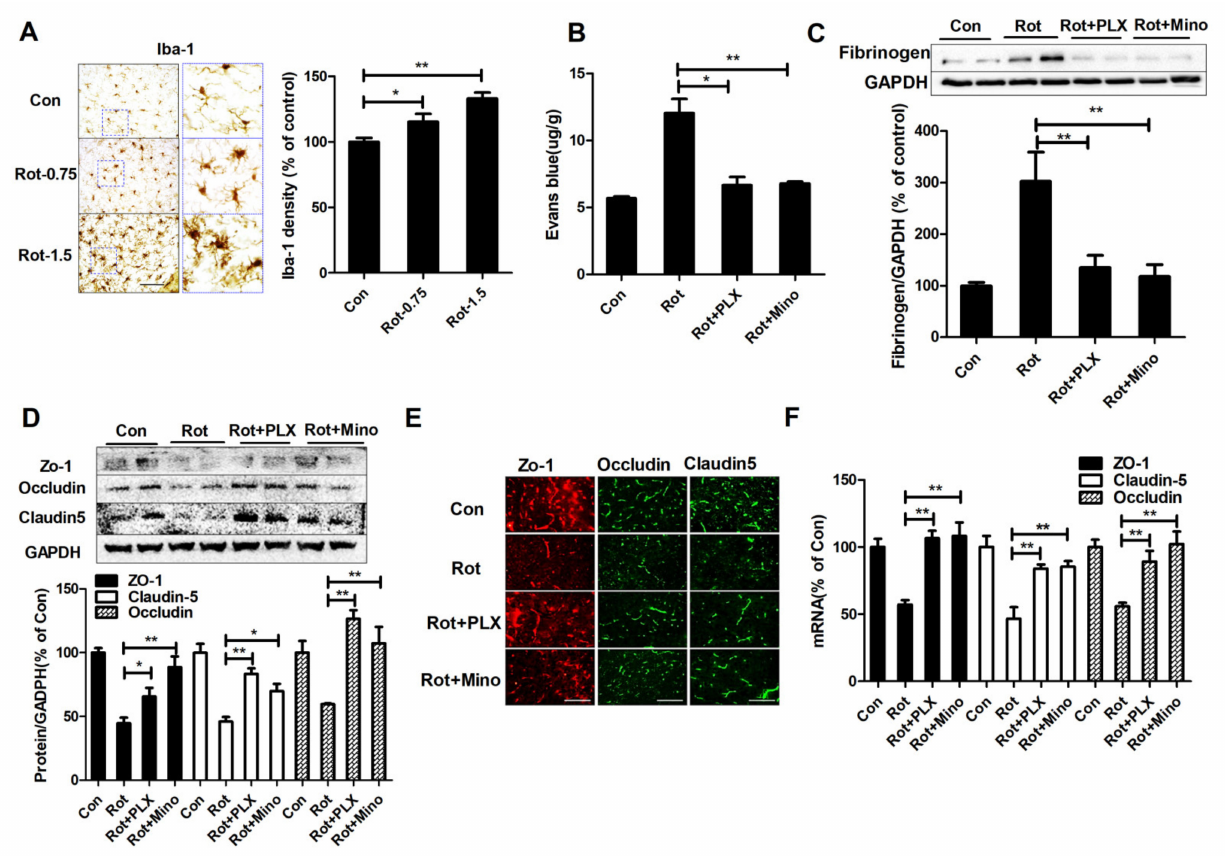
Figure 3. Microglia mediates rotenone-induced BBB dysfunction in mice. ( A ) Representative images of microglial staining and the quantification of Iba-1 staining density. ( B ) The content of Evans blue in mice for each group. ( C ) Representative blots of fibrinogen in mice for each group and the quantification of blots. ( D ) Representative blots of ZO-1, occludin, and claudin-5 in mice for each group and the quantification of blots. ( E ) Representative images of ZO-1, occludin, and claudin-5 staining in the SN of mice. ( F ) Gene expressions of ZO-1, claudin-5, and occludin in the midbrain of mice. n = 3–6. * p < 0.05, ** p < 0.01; scale bar = 100 µ m. Con: vehicle-treated mice group;